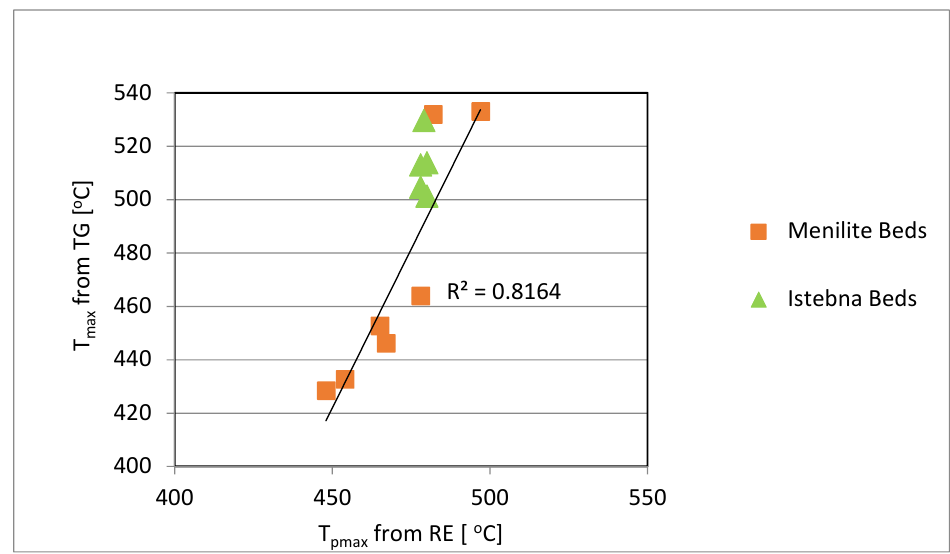
Figure 14. Correlation diagram of the maximum temperature at which the maximum decomposition of organic matter occurs in TG and Rock-Eval pyrolysis.